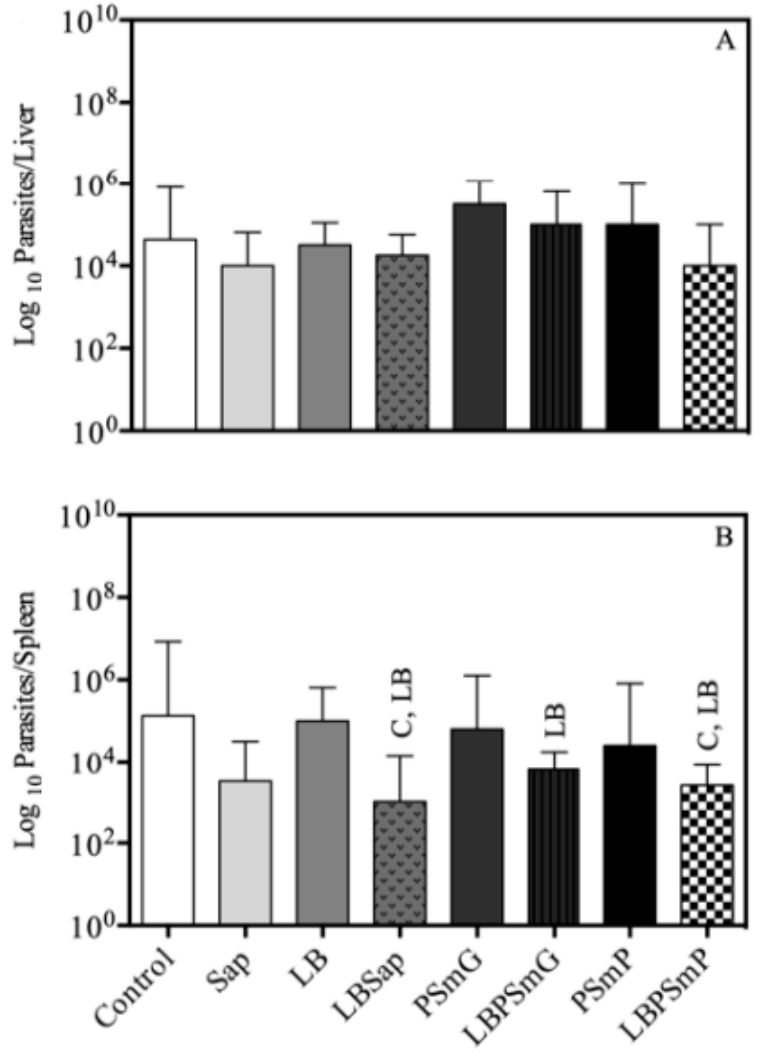
Figure 4. Parasite burden in liver (A) and spleen (B) after experimental challenge by limiting dilution assay. The x axis represents the experimental groups and the y axis represents the mean and standard deviation in log units of parasite burden in liver and spleen. Statistical differences ( p < 0.05, Mann–Whitney) between groups are indicated by acronyms in the correlated group(s). LEGEND: C—Control (white bar); Sap—Saponin (light gray bar); LB— L. braziliensis antigen (medium gray bar); LBSap— L. braziliensis antigen plus saponin (dot medium gray bar); PSmG—Empty submi- crometric large particle (dark gray bar); LBPSmG—Submicrometric large particle plus Leishmania braziliensis antigen (vertical line dark gray bar); PSmP—Empty submicrometric small particle (black bar); LBPSmP—Submicrometric small particle plus Leishmania braziliensis antigen (checkered